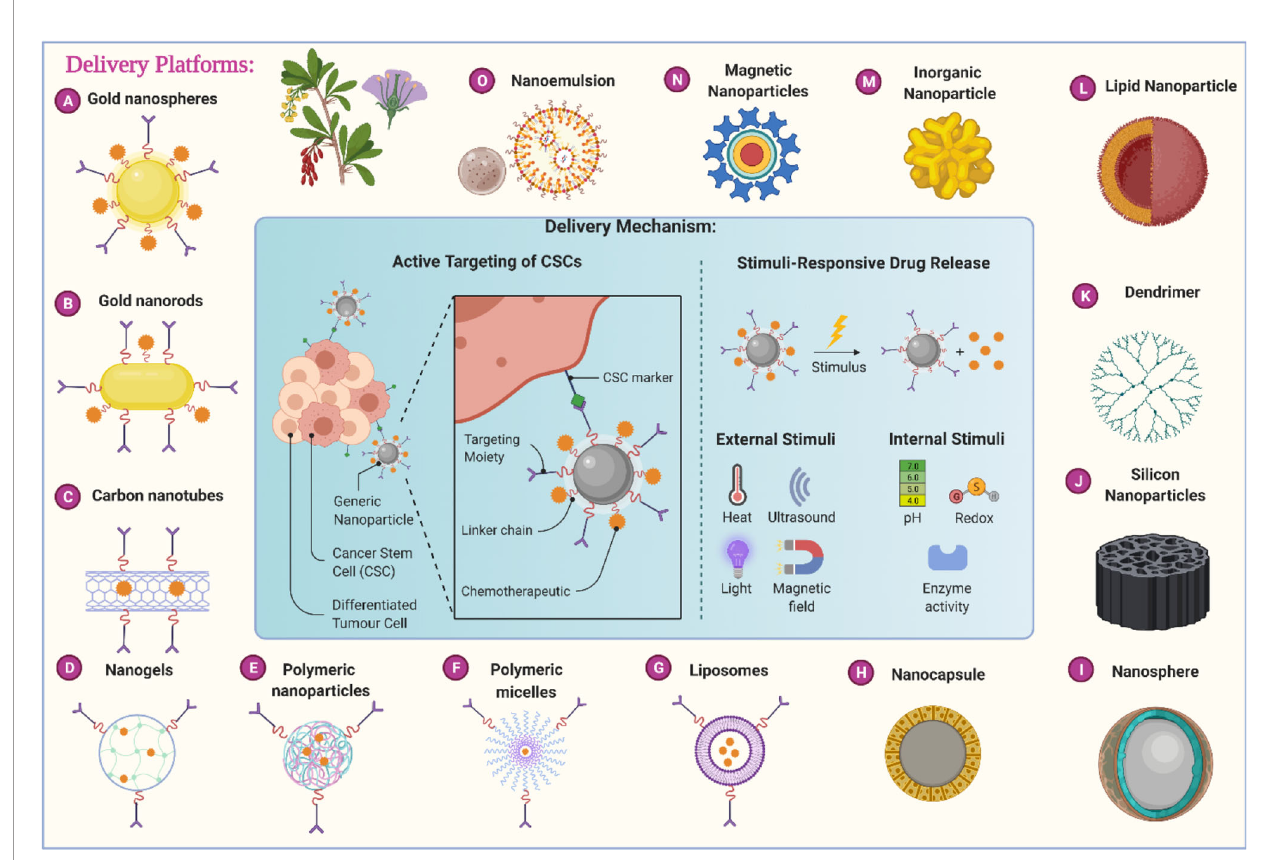
FIGURE 2 | Different nanotechnology-based carrier platforms for the ef fi cient delivery of anticancer phytochemicals and different delivery